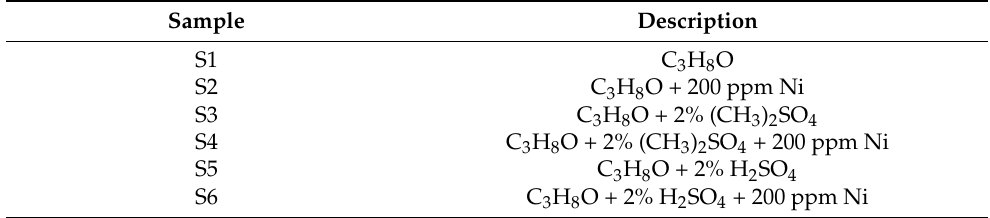
Table 3. Samples